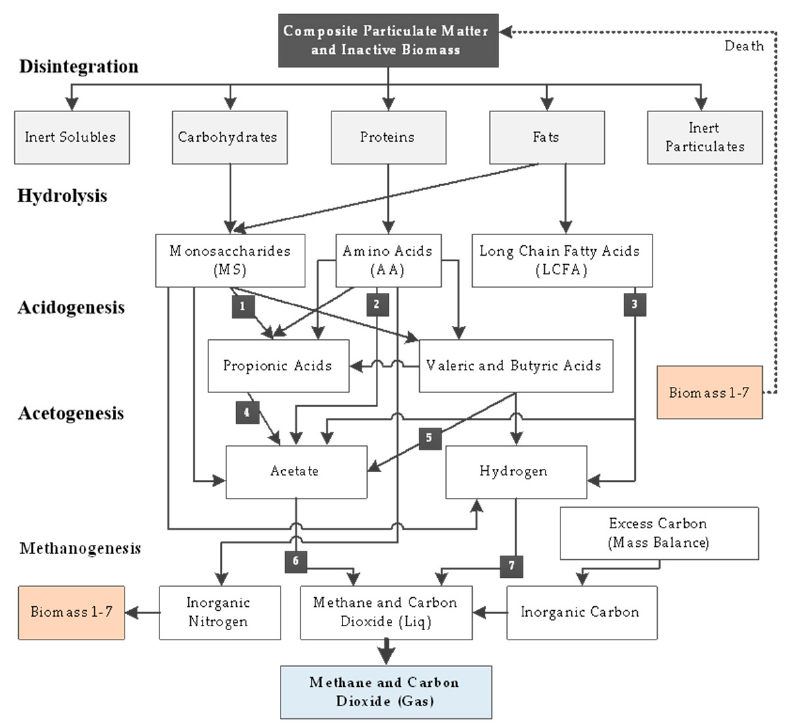
Figure 1. The reaction paths in ADM1 d escribed in [8] .